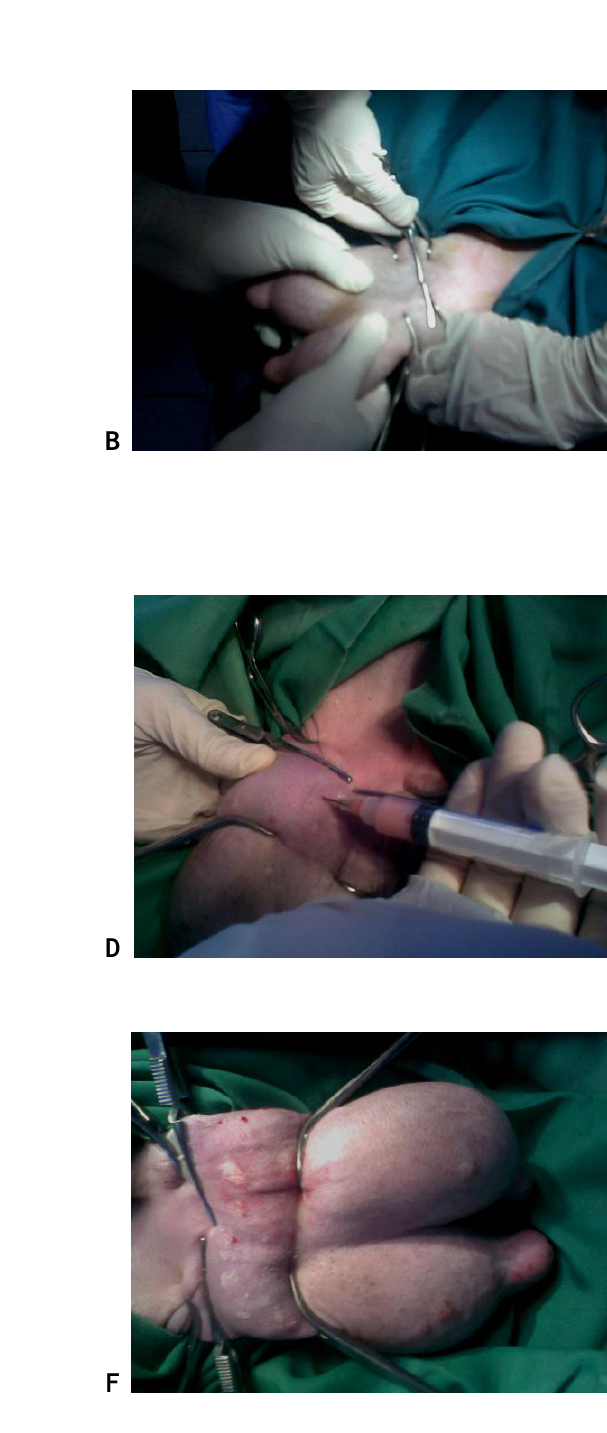
Fig: Photograph show prepation of the area and procedure of injection. A-Shows the application of towel clips and bulldog forceps.B -Bull dog forceps applied in the same line. C- Injection of acrylic denture base material into spermatic cord.D-Other site of injection. E -Full all spermatic cord.F -Solidation of material and hardening of spermatic